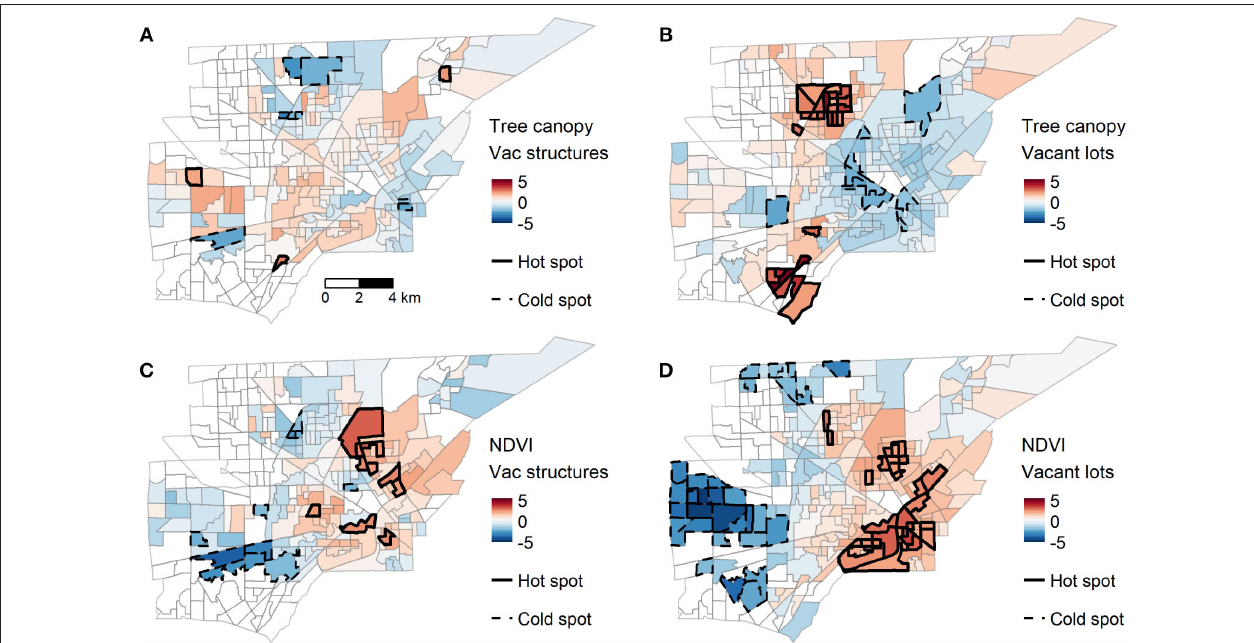
FIGURE 4 | (A–D) Results of Getis-Ord G * i analysis of the discrepancy in greenness between vacant parcels and their comparable occupied matches. Mapped values are z -scores, where darker reds indicate increasingly strong positive differences between vacant parcels and their occupied matches, and darker blues indicate differences that are increasingly smaller or negative. Hot (cold) spots are clusters of block groups that have values that are significantly higher (lower) than expected at the p < 0.05 level. Hot spots can be interpreted as areas where vacant parcels are particularly green compared to their occupied matches. Cold spots can be interpreted as areas where occupied parcels are either greener than or quite similar in greenness to vacant parcels. White block groups had < 10 matched pairs and were excluded from the